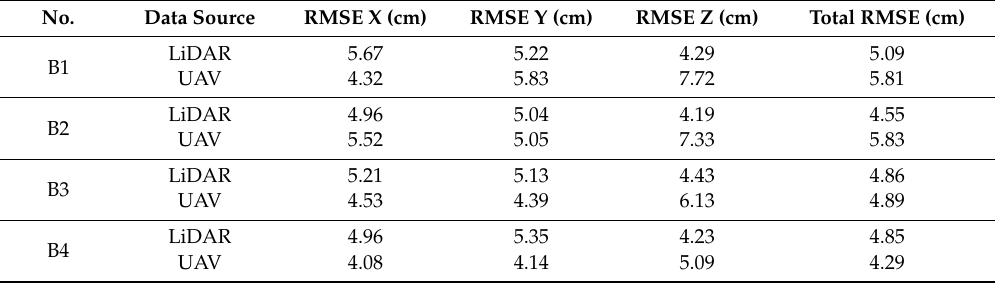
Figure 13. Comparisons of point clouds generated from laser scanning and UAV photogrammetry for stockpile-covered modeling: ( a ) and ( b ) are the point clouds generated from laser scanning and UAV photogrammetry, respectively; ( c ) and ( d ) are the respective cross sections of ( a ) and ( b ) along the x-axis; ( e ) and ( f ) are the respective cross sections of ( a ) and ( b ) along the y-axis. Table 5. Error statistics of GCPs measured using the stockpile-covered and stockpile-free surface models in a non-dynamic environment. These errors are derived from differencing with GCPs that serve as a reference. RMSE: root mean square error. B1–B4 denote the number of barges.